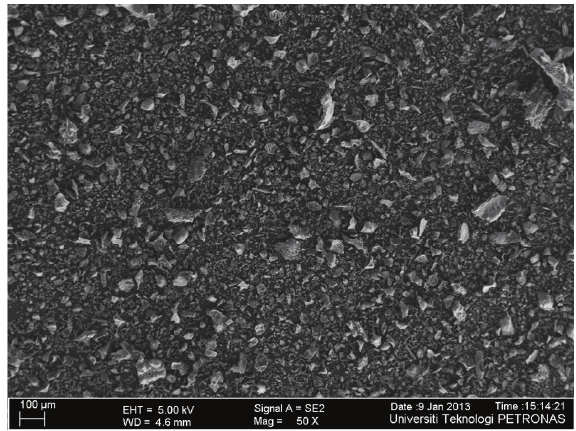
Figure 5: Microstructure of rice husk ash through field emission scanning electron microscope (FESEM) showing particle size dis-